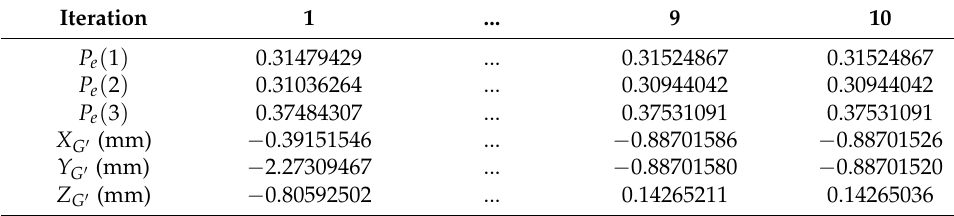
Table 17. Results of second experiment.